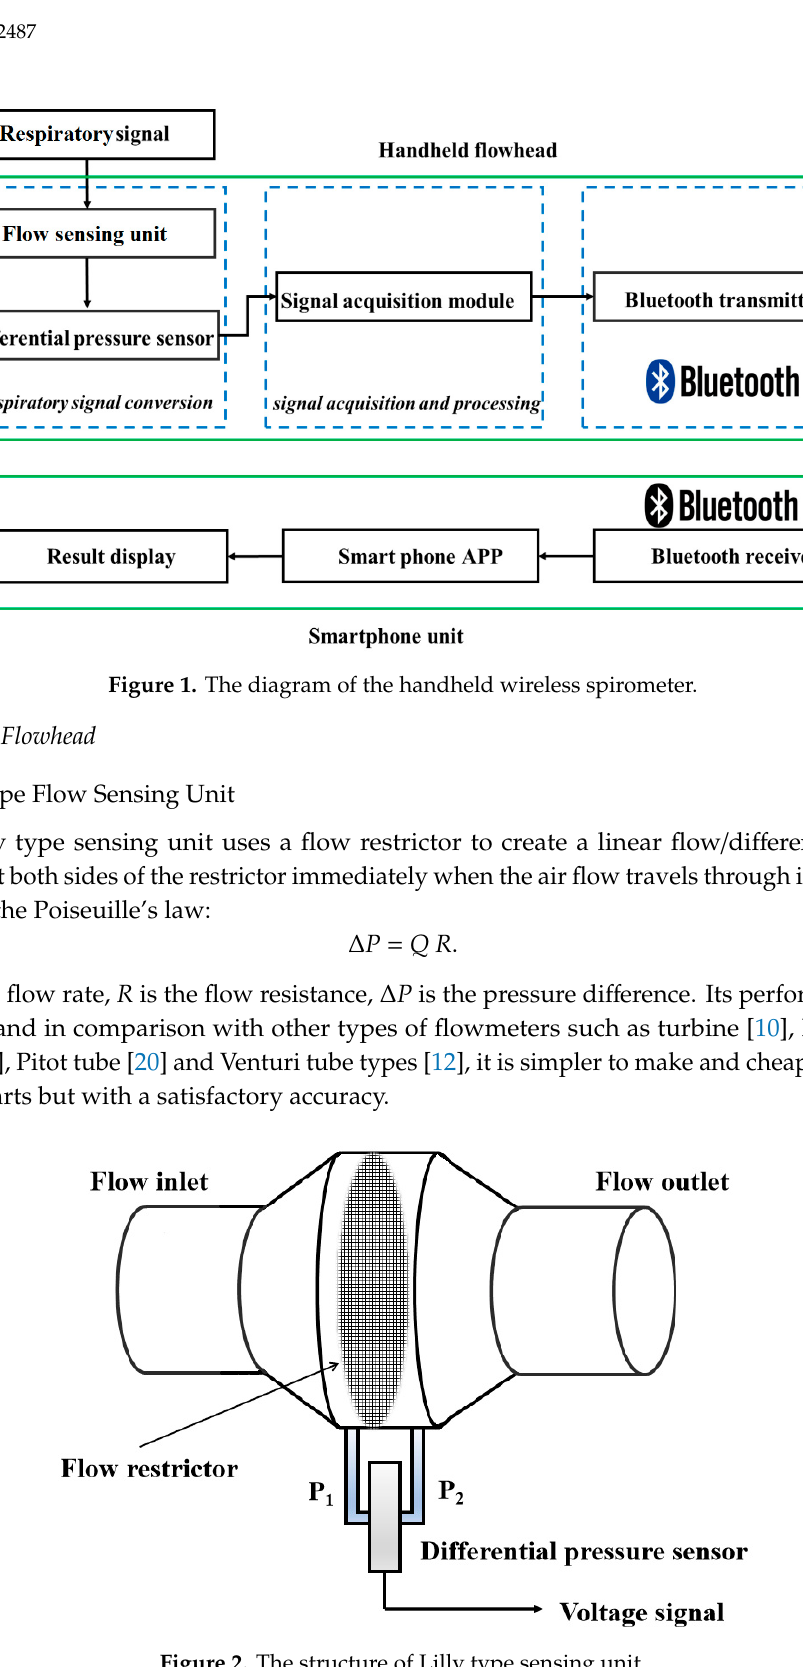
Figure 2. The structure of Lilly type sensing unit.